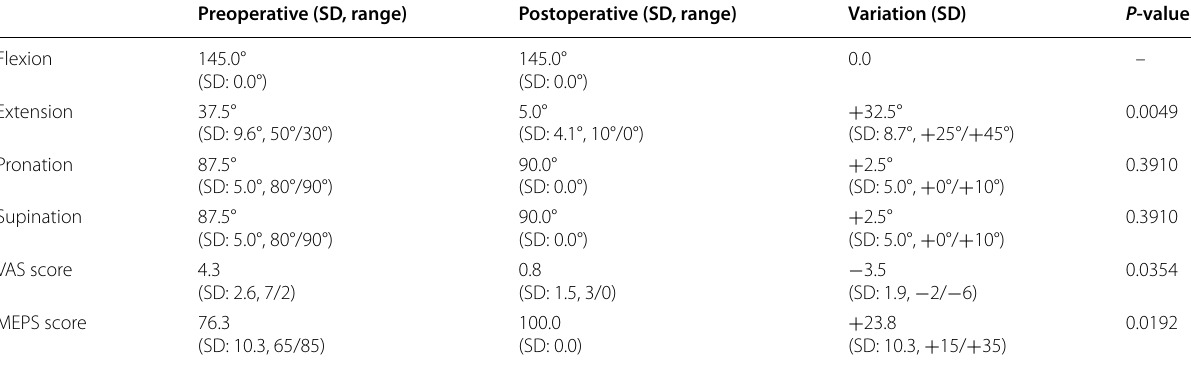
Table 5 PI group clinical outcomes (follow-up 60 months) Preoperative (SD, range)